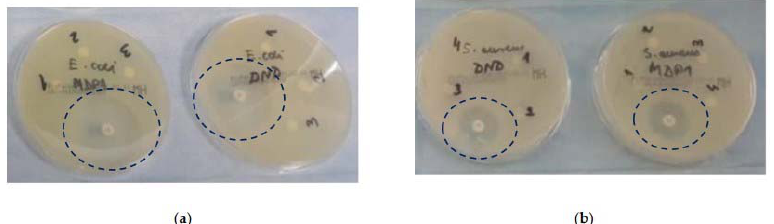
Figure 4. Bacteriostaticity assessment test of diamond nanoparticles: ( a ) MDP1 and DND test samples against Escherichia coli bacteria; and ( b ) MDP1 and DND test samples against Staphylococcus aureus bacteria.